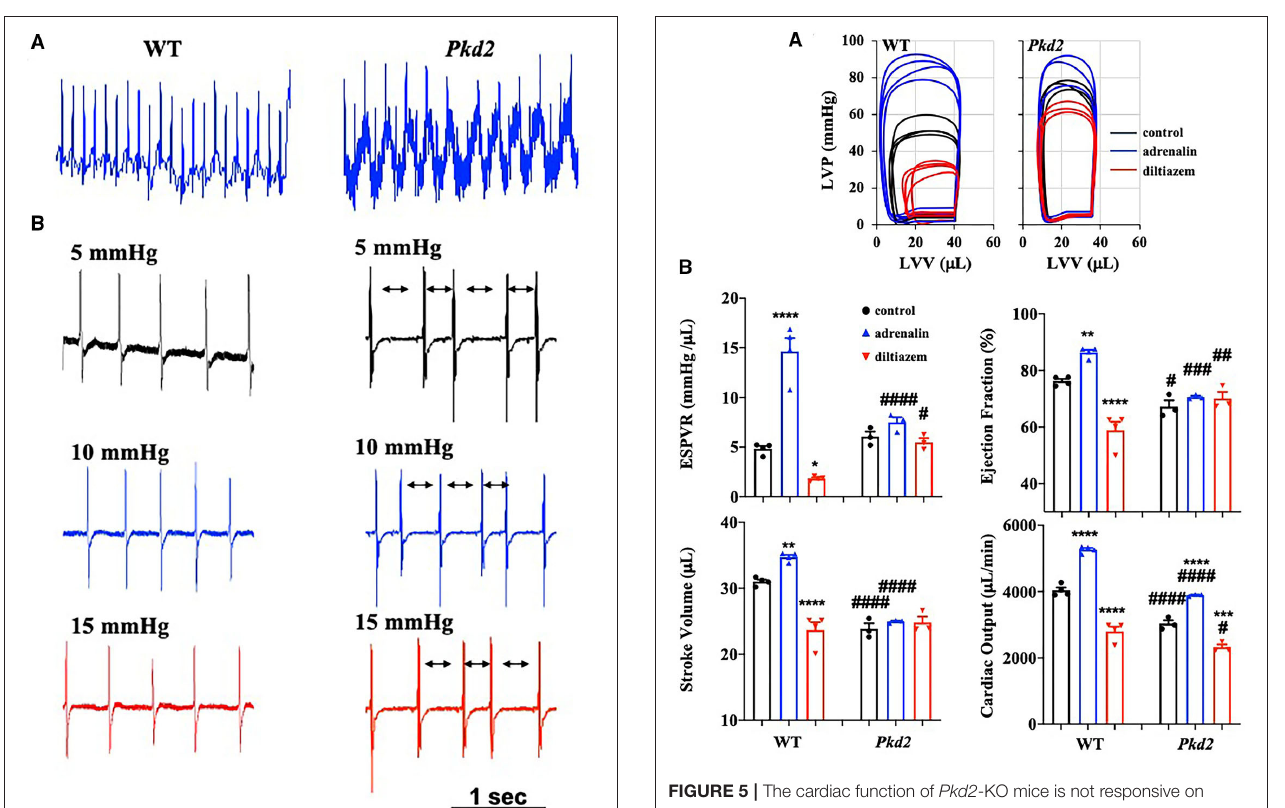
FIGURE 5 | The cardiac function of Pkd2 -KO mice is not responsive on changes in cardiac stresses. (A) Individual graphs of the relationship between left ventricle pressure (LVP) and left ventricle volume (LVV) heart function are shown before and after injection of adrenaline (4 mg/L) and diltiazem (0.08 mg/L) in wild-type (WT) and Pkd2 -KO (Pkd2) hearts. (B) End-systolic-pressure-volume relationship (ESPVR, an index of systolic contractility function), stroke volume, ejection fraction, and cardiac output are used to evaluate the heart responses on positive-stress (adrenaline) and negative-stress (diltiazem). N = 3–4 mice for each WT and Pkd2 -KO age-matched 6 months old. Statistical significance between control and treatment is indicated with asterisk (*) sign; between genotypes in hash (#). * p < 0.05; ** p < 0.01; *** p < 0.001; **** p < 0.0001 compared to control within the same genotype. # p < 0.05; ### p < 0.001; #### p < 0.0001 compared to the corresponding